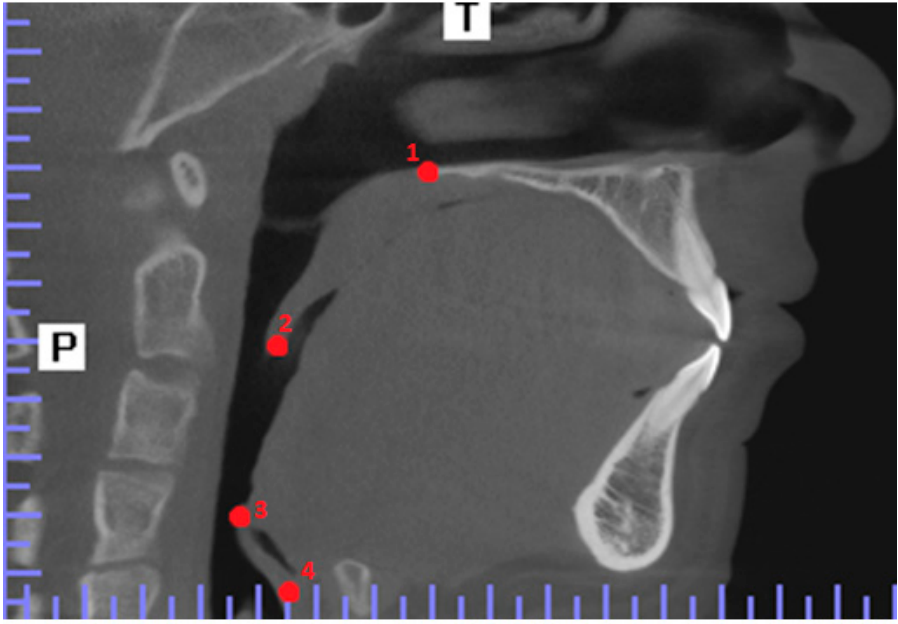
Figure 1. Landmarks used in CBCT analysis: posterior nasal spike (1), the tip of the uvula (2), the top of the epiglottis (3), the base of the epiglottis (4).